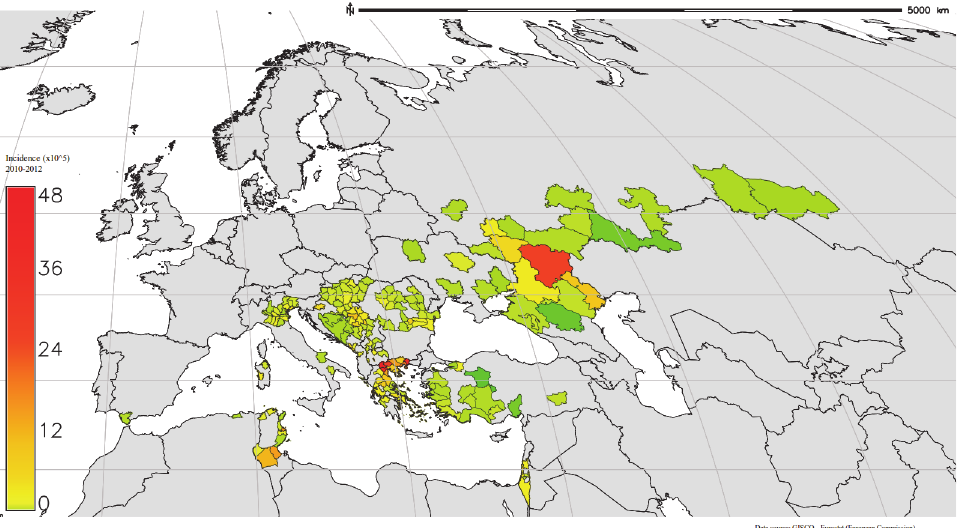
Fig 1. Spatial variation in cumulative WNF incidence (cases per100,000 population) between 2010 and 2012 is indicated in colour, within areas delineated using NUTS3/GAUL1 administrative boundaries. Areas with no reported cases of WNF are shown in grey, and delineated using Country boundaries. Peak incidences are reported in red, these being in Volgograd Oblast, North Eastern Greece and Central